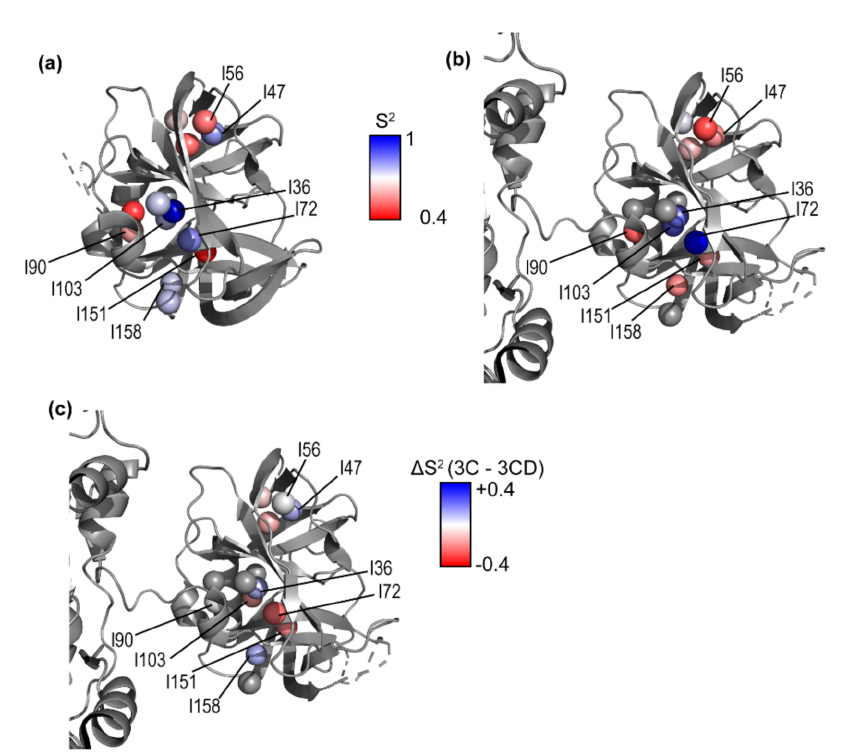
Figure 5. Methyl axis order parameters for 3C and the 3C domain in 3CD. Methyl axis order parameters are plotted as colored spheres ranging from 0.4–1 (red to blue) as indicated for ( a ) 3C and ( b ) 3C domain of 3CD. ( c ) Differences in methyl axis order parameters between 3C and 3CD ( ∆ S 2 = S 2 (3C) − S 2 (3CD)) are plotted as colored spheres, ranging from − 0.4 to +0.4 (red to